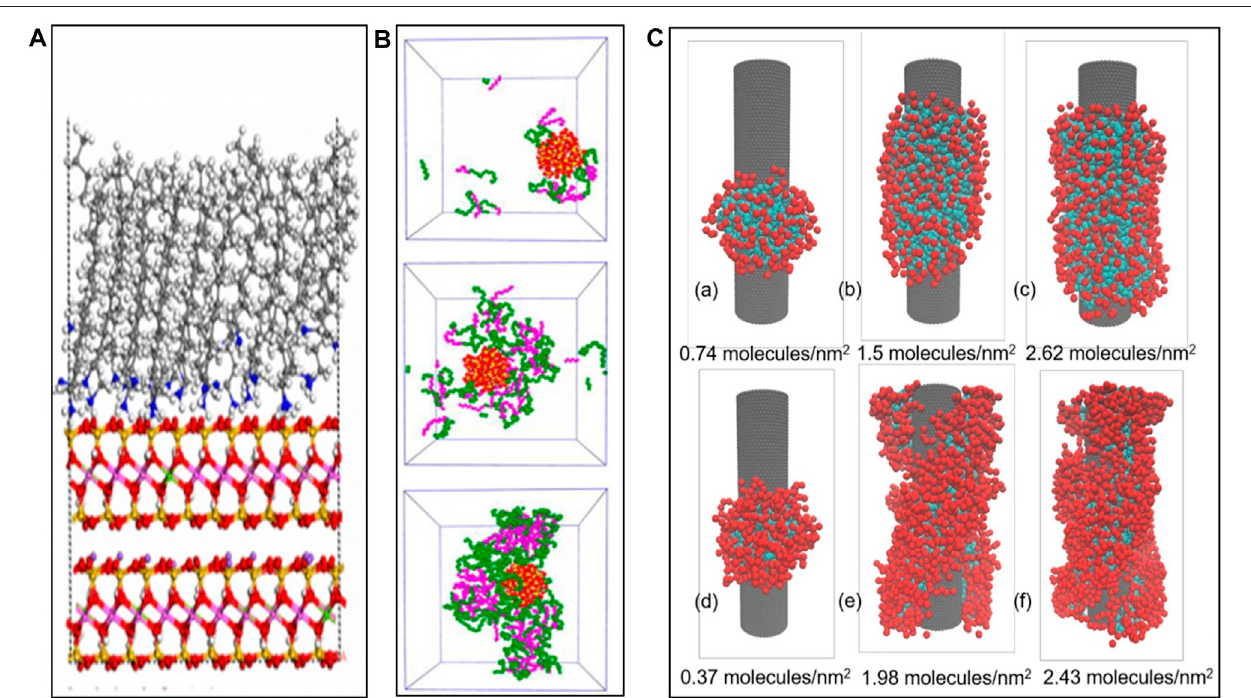
FIGURE 1 | Surfactant adsorption on NPs through different